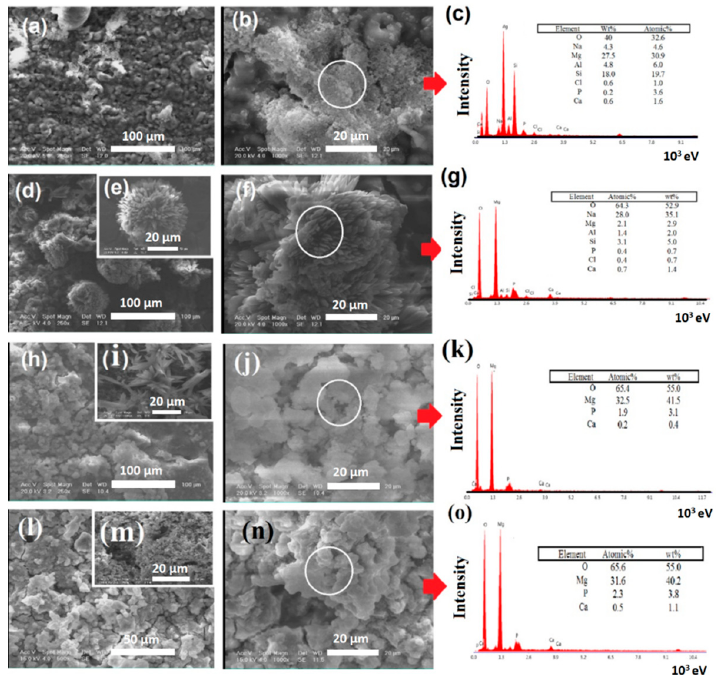
Figure 3. SEM images of ( a , b ) MAO, ( d – f ) MAO/P, ( h – j ) MAO/P/3B, ( l – n ) MAO/P/5B, and EDS spectra of ( c ) MAO, ( g ) MAO/P, ( k ) MAO/P/3B, and ( o ) MAO/P/5B after seven days of immersion in SBF.